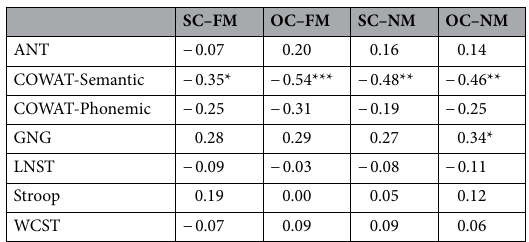
Table 1. Pearson correlation coefficients between the scores of neuropsychological tests and RTs in each condition. SC–FM supporting context with familiar metaphor, OC–FM opposing context with familiar metaphor, SC–NM supporting context with novel metaphor, OC–NM opposing context with novel metaphor, ANT attention network test, COWAT controlled oral word association test, GNG go/no-go, LNST letter number